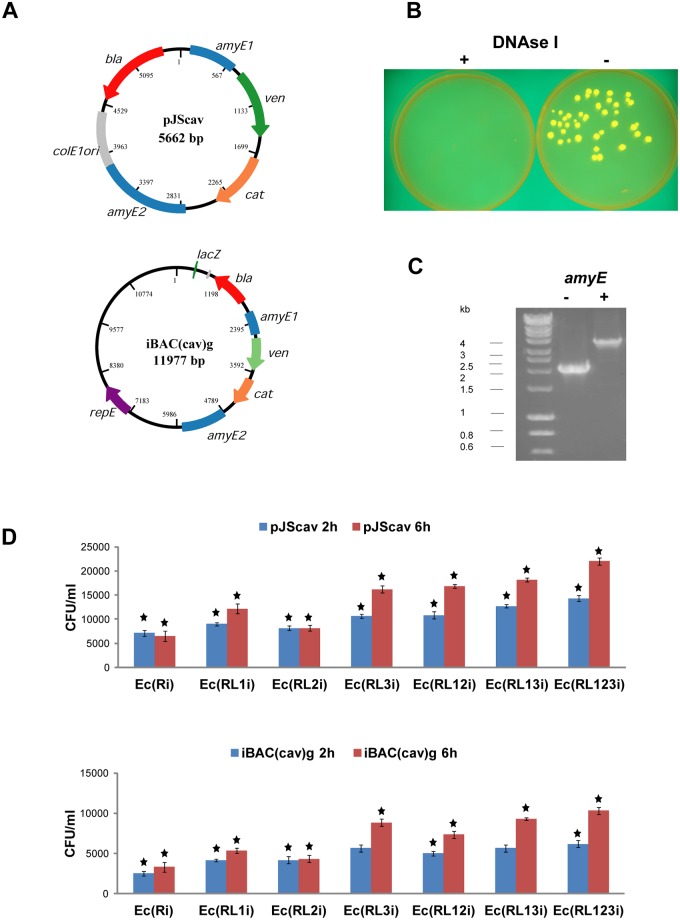
Interchassis DNA transfer from E. coli to B. subtilis by induced cell lysis.(A) pJSav and iBAC(cav) maps. pJSav and iBAC(cav) encode genetic circuits cat and ven flanked by the integration sequences homologous to amyE target site in the B. subtilis chromosome. cat and ven encode Bacillus-specific chloramphenicol resistance and yellow fluorescent protein gene mVenus, respectively. (B) DNAse I suppressed DNA transfer from E. coli to B. subtilis in the culture media. (C) Integration of the pJSav and iBAC(cav)-borne genetic circuits cat and ven into amyE locus of the B. subtilis chromosome. HyperLadder 1kb (Bioline) has been used as the molecular weight marker. (D) Number of B. subtilis transformants per ml of mixed E. coli and B. subtilis cultures using pJSav and iBAC(cav) 2 hours and 6 hours after temperature induced lysis. The number of transformants was highest with the strain Ec(RL123i) harbouring lysis genes from all three bacteriophages. T-tests were conducted to compare the differences in pJScav and iBAC(cav)-encoded DNA transfer between Ec(RL123i) and strains harbouring fewer than three lysis genes. Stars indicate significant difference in the DNA transfer between Ec(RL123i) and the other investigated E. coli strains. The differences were significant (p<0.05) in all cases except when compared to iBAC(cav) transfer in Ec(RL3i) and Ec(RL13i) 2 hours after induction.